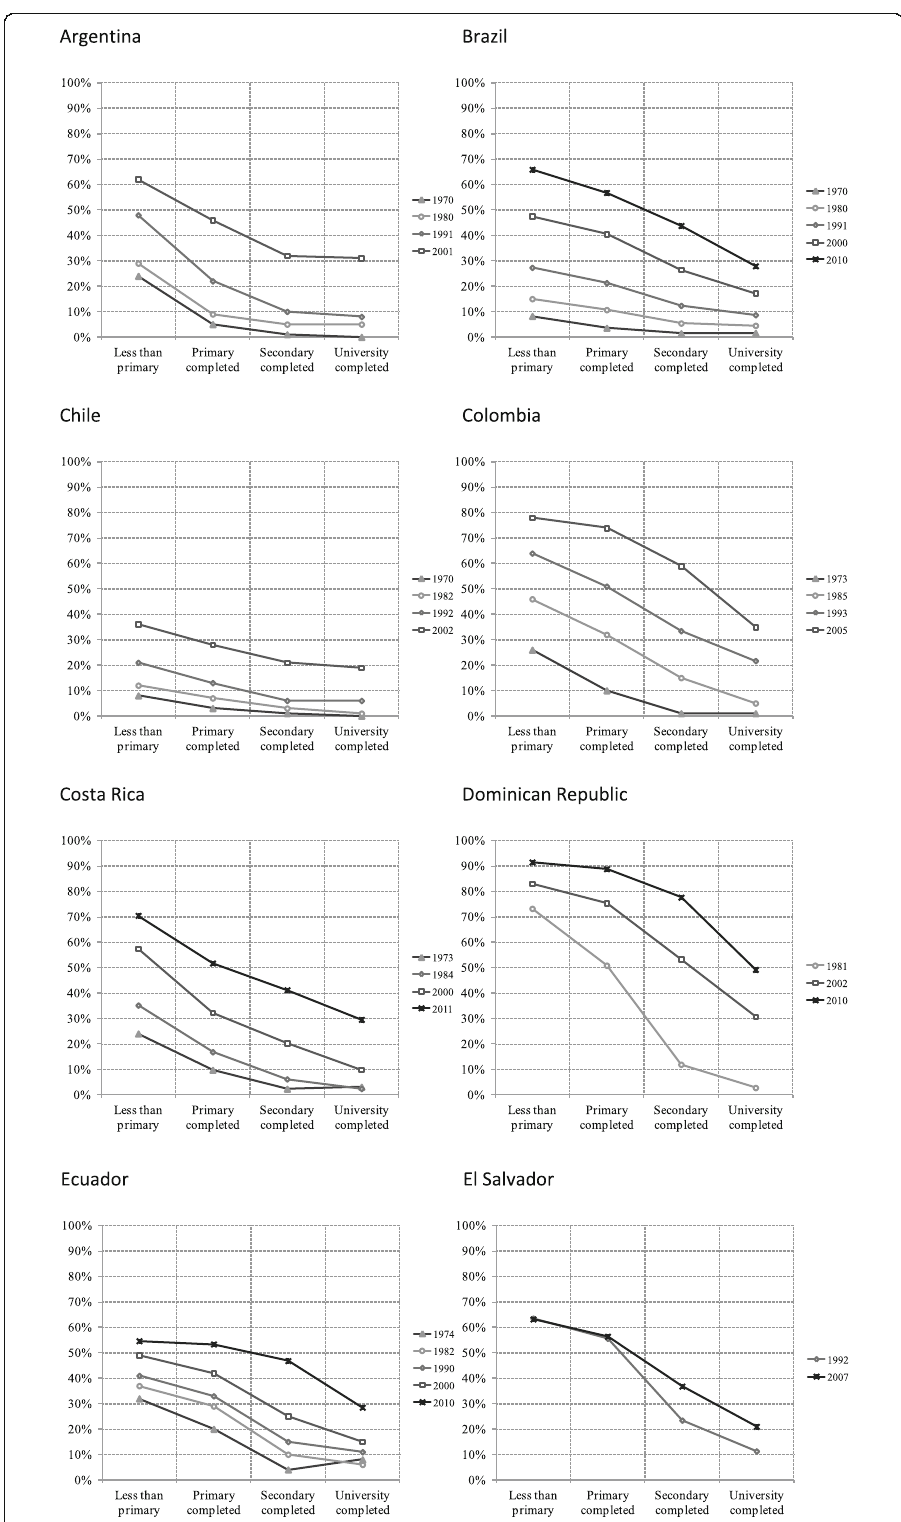
Fig. 7 The share of consensual unions among all unions among women 25 – 29, according to education. Latin American populations, 1970 – 2010. Source: Esteve et al.